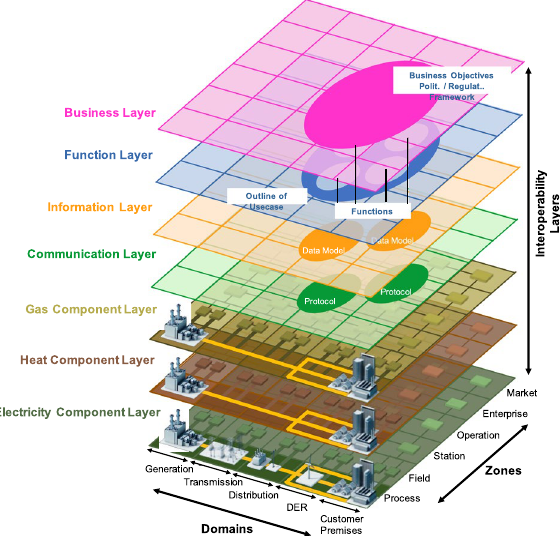
Fig. 1 General-purpose architectural model for MES engineering application